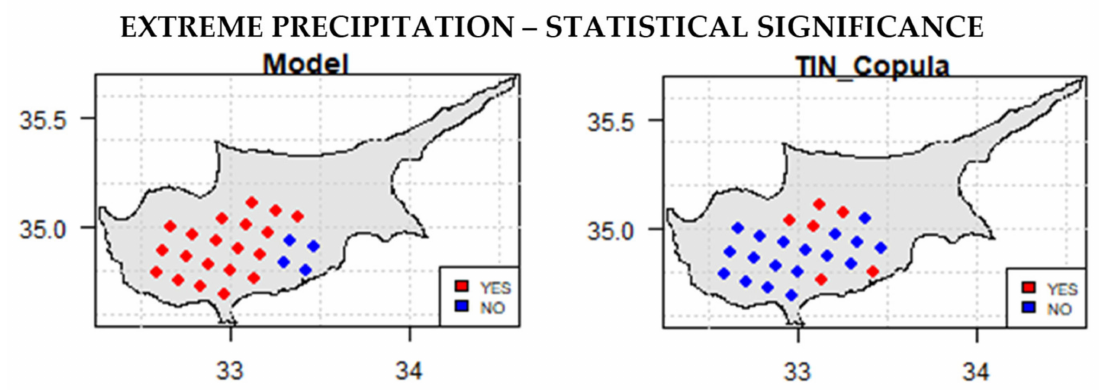
Figure 9. Grid points with statistically significant biases, before and after the application of the TIN-Copula bias correction (t-test, level of significance